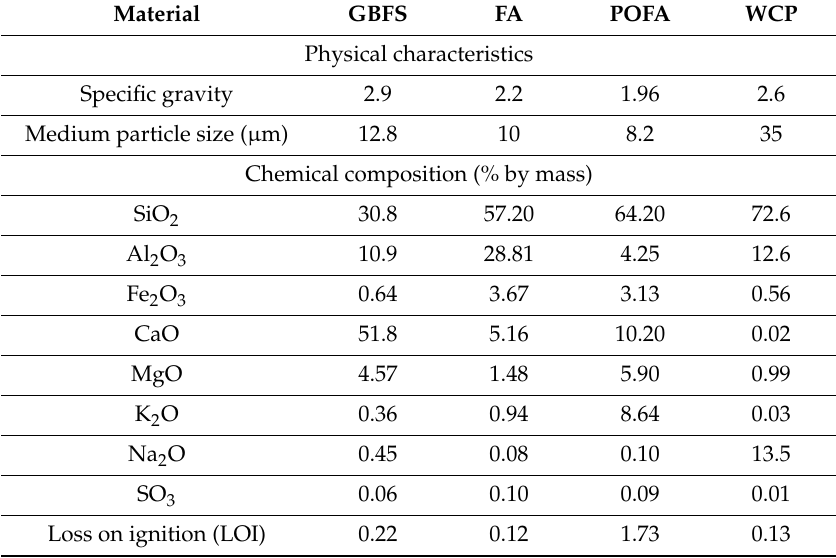
Table 1. Physical properties and chemical composition of studied waste materials.